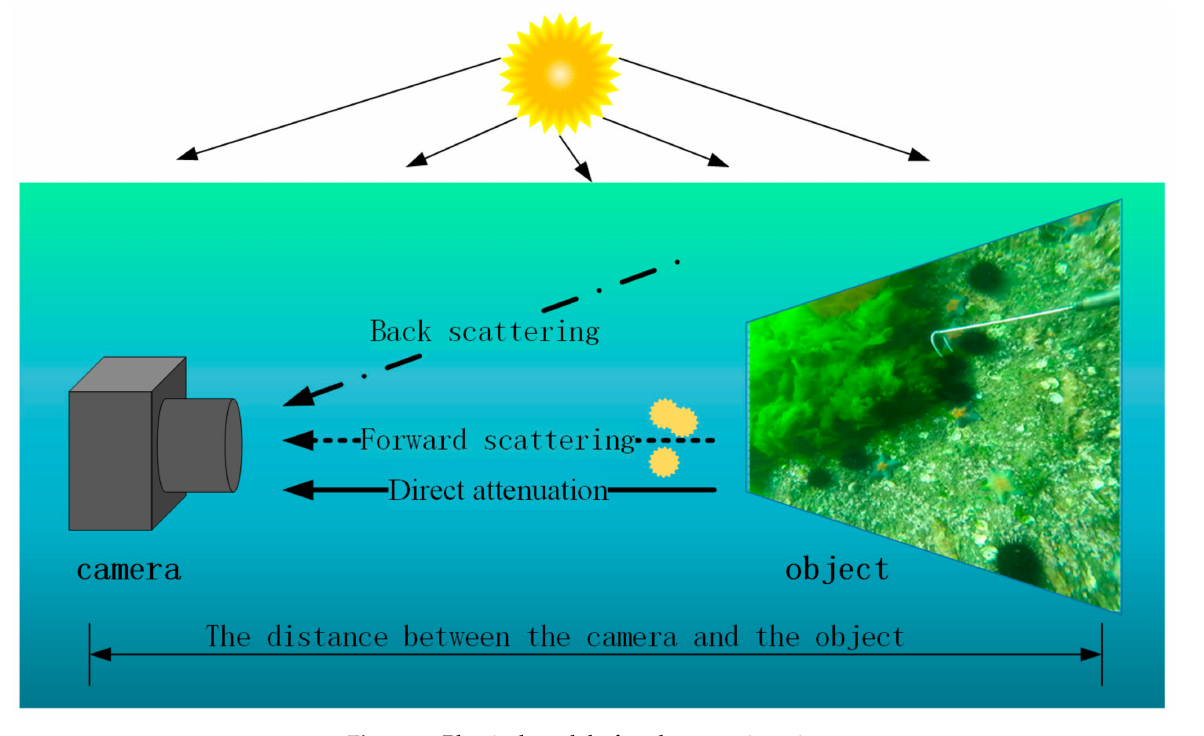
Figure 2. Physical model of underwater imaging.